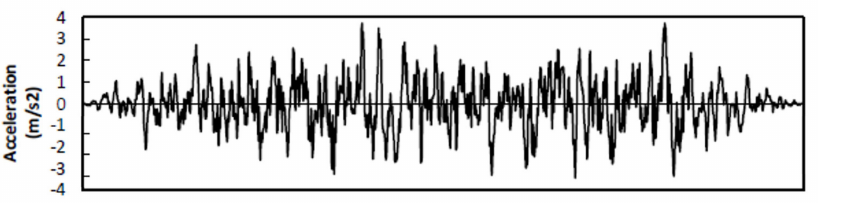
Figure 27. Ground motion accelerarogram (time history for the return period of 2000 years—0.38 g).